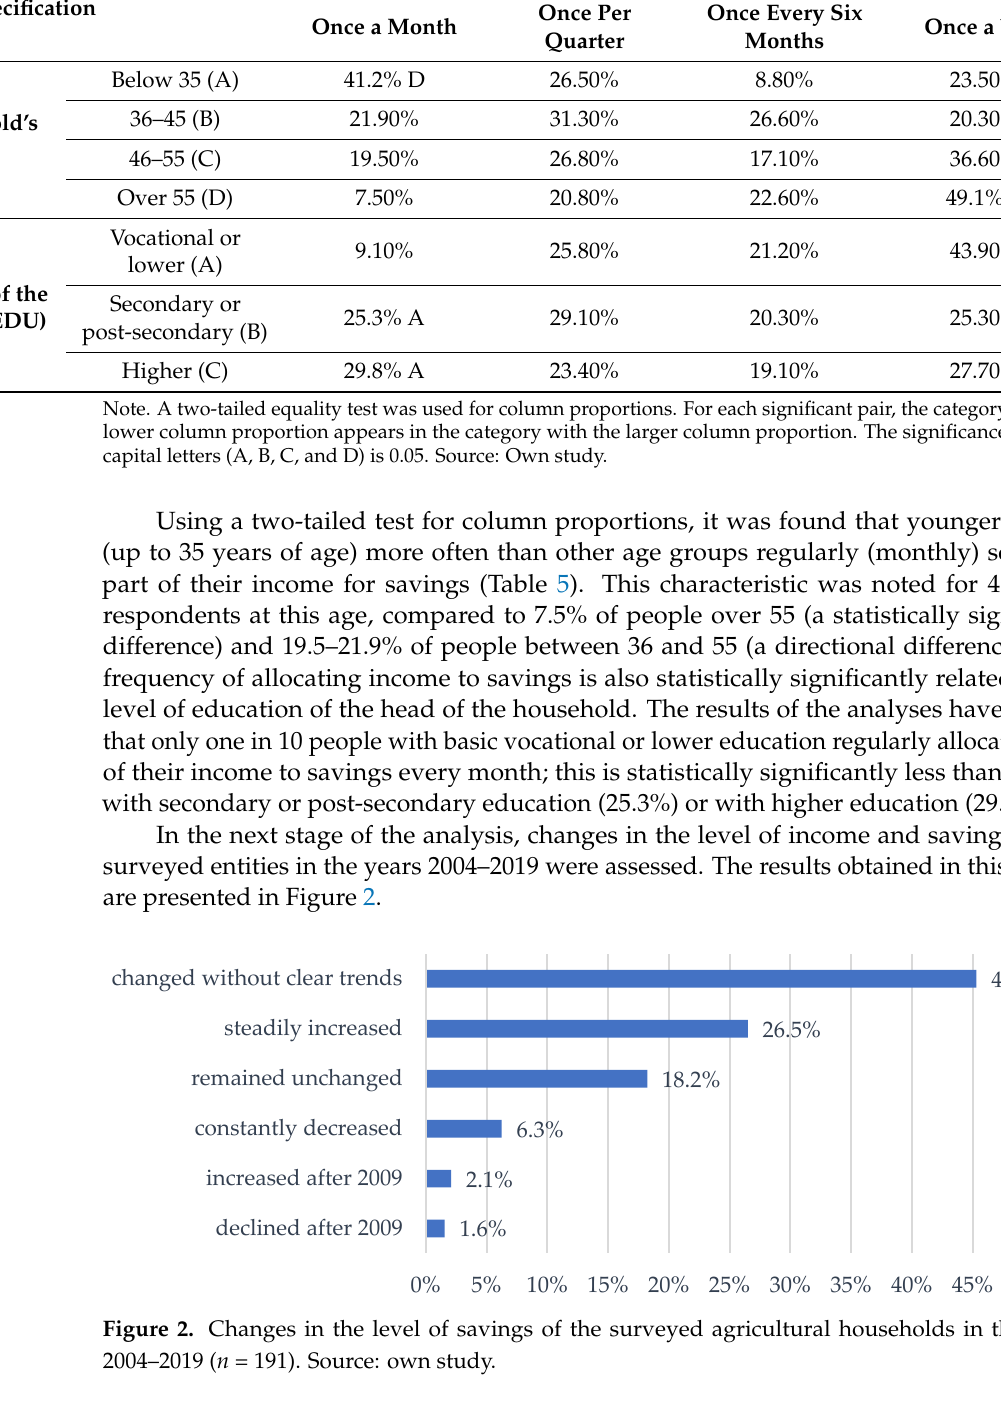
Table 5. The frequency of collecting savings and selected characteristics of the surveyed agricultural households ( n = 191).